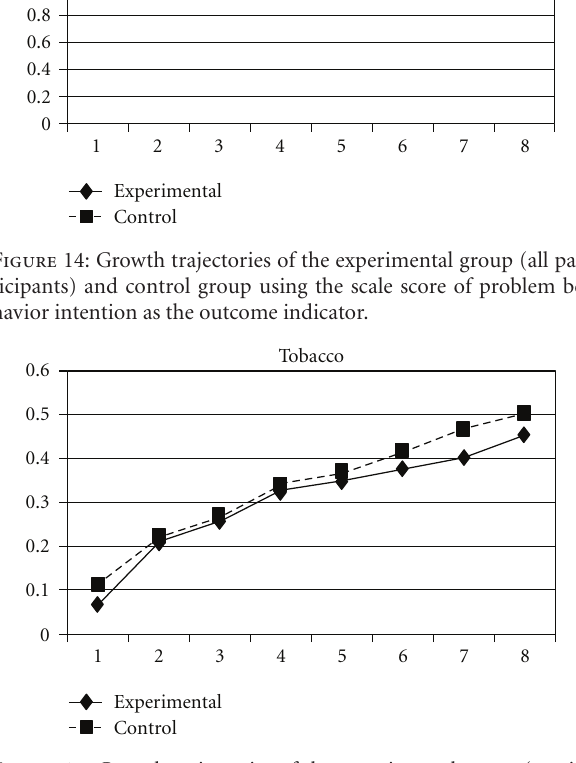
Figure 15: Growth trajectories of the experimental group (partic- ipants who perceived the program as e ff ective) and control group using the scale score of problem behavior intention as the outcome